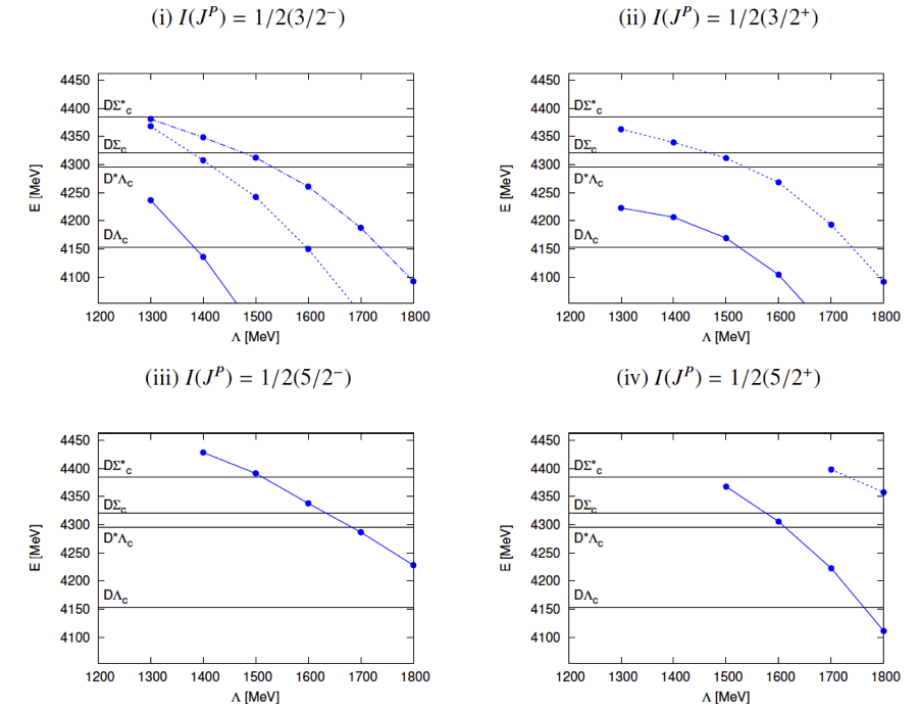
Figure 3. Cuto ff Λ dependence of the obtained energies E in for the pentaquark states with J P = + − and 5 − The solid, dashed and dot-dashed lines correspond to the obtained energy spectra of − , 3 3 , 5 2 2 2 2 first, second and third states, respectively. The black horizontal lines show the meson-baryon thresholds.